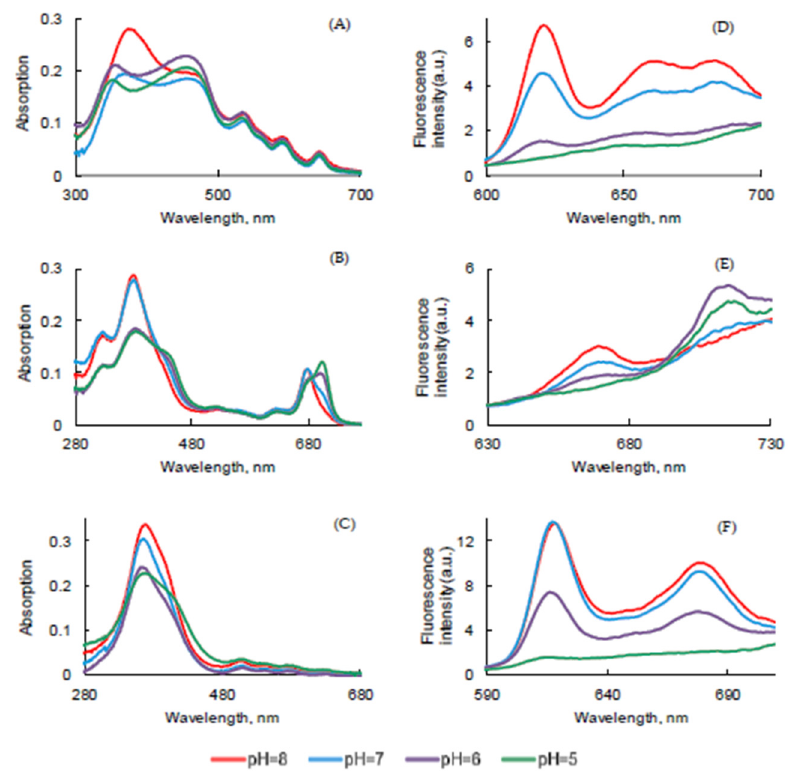
Figure 12. UV-visible absorption ( A – C ) and fluorescence emission ( D – F ) spectra ( λ exc = 400 nm for PpIX and PF and 415 nm for PPa) of PpIX ( A , D ), PPa ( B , E ), and PF ( C , F ) in PBS under different pH ( c = 3.1 μ M) at room temperature.